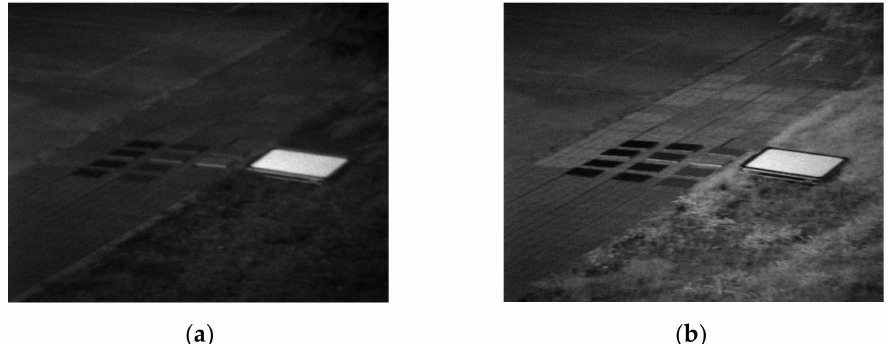
Figure 8. Single band grayscale images at different wavelengths. ( a ) Single band grayscale images at 553 nm. ( b ) Single band grayscale images at 801 nm.